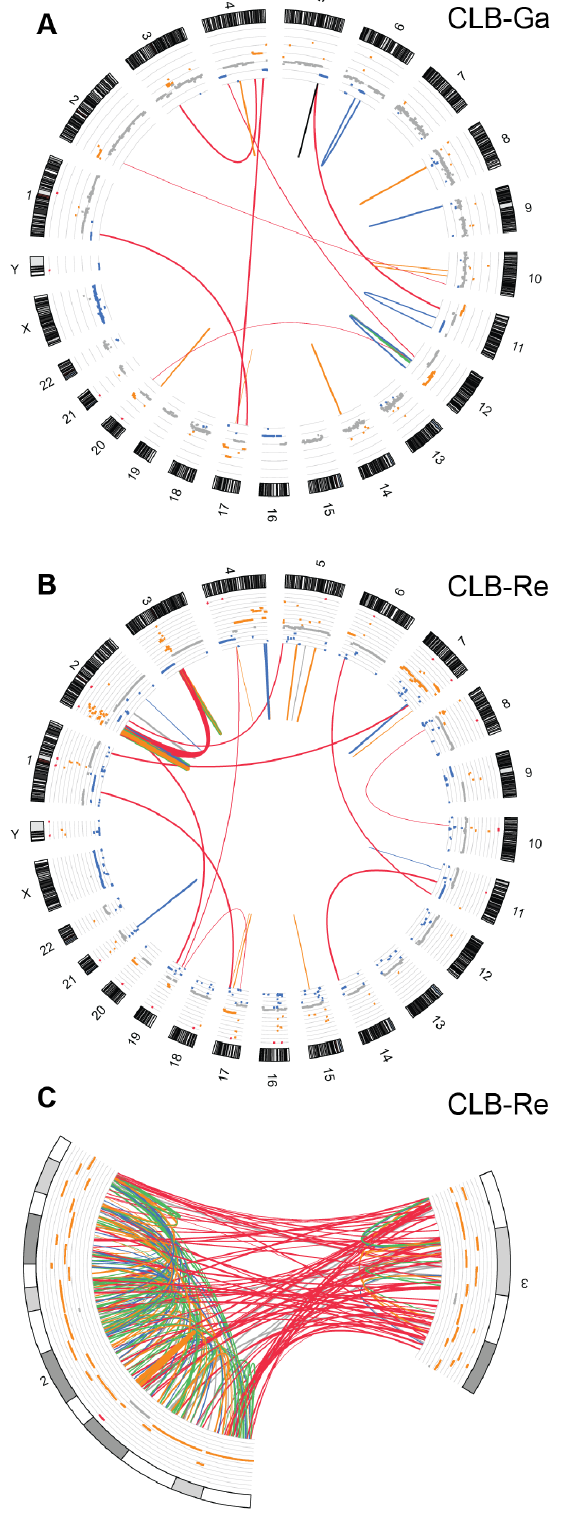
Figure 1. Genome-wide profile of predicted SVs in CLB-Ga and CLB-Re cell lines. All inter-chromosomal rearrangements and intra- chromosomal SVs encompassing regions longer than 50 kb identified in mate-pair sequencing are visualized using Circos [41]. Chromosomes appear as ideograms. The outer ring shows a representation of